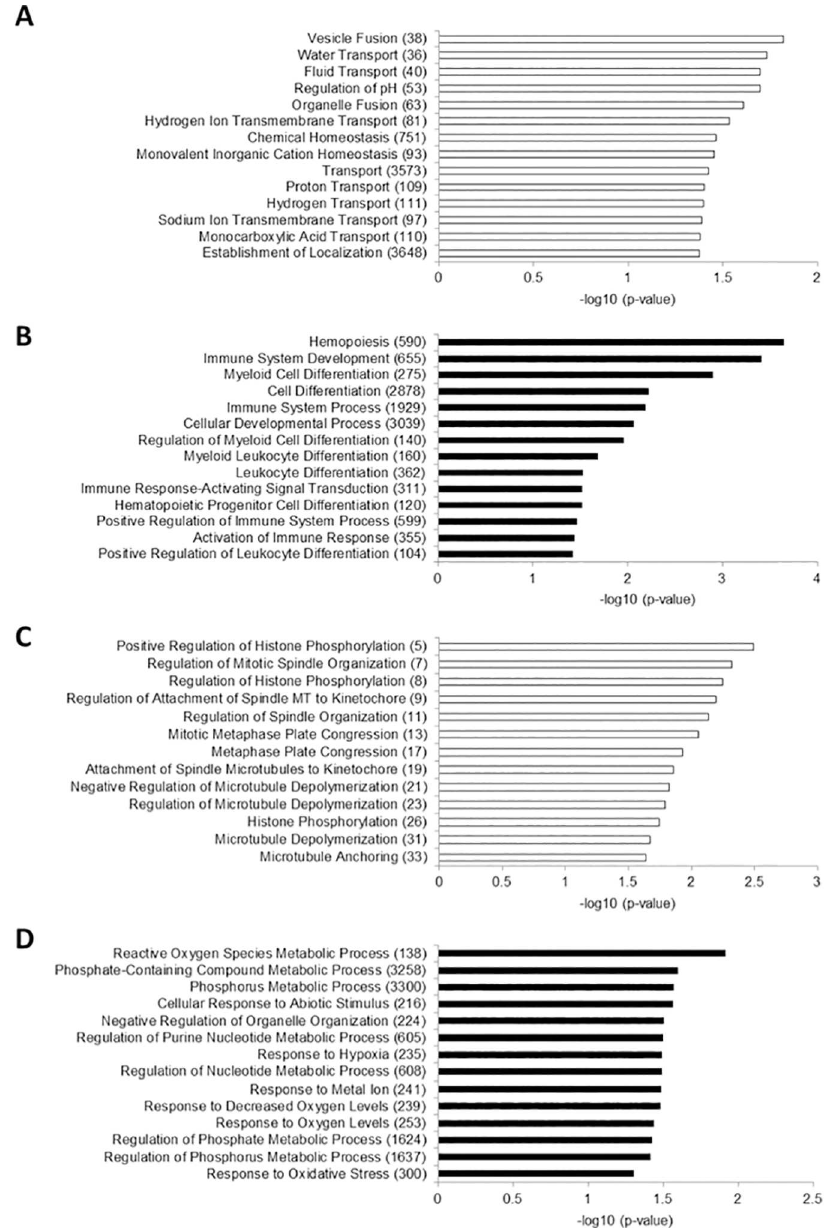
Fig 4. GeneOntology (GO) categoriesmoststronglyenrichedamong probesin FECDCE. Numberof represented probesineachcategoryisinparentheses aftercategoryname.(A) GenebodyDNAhypomethylation, (B) GenebodyDNAhypermethylation,(C) PromoterDNAhypomethylation, and(D) PromoterDNAhypermethyl- ation.